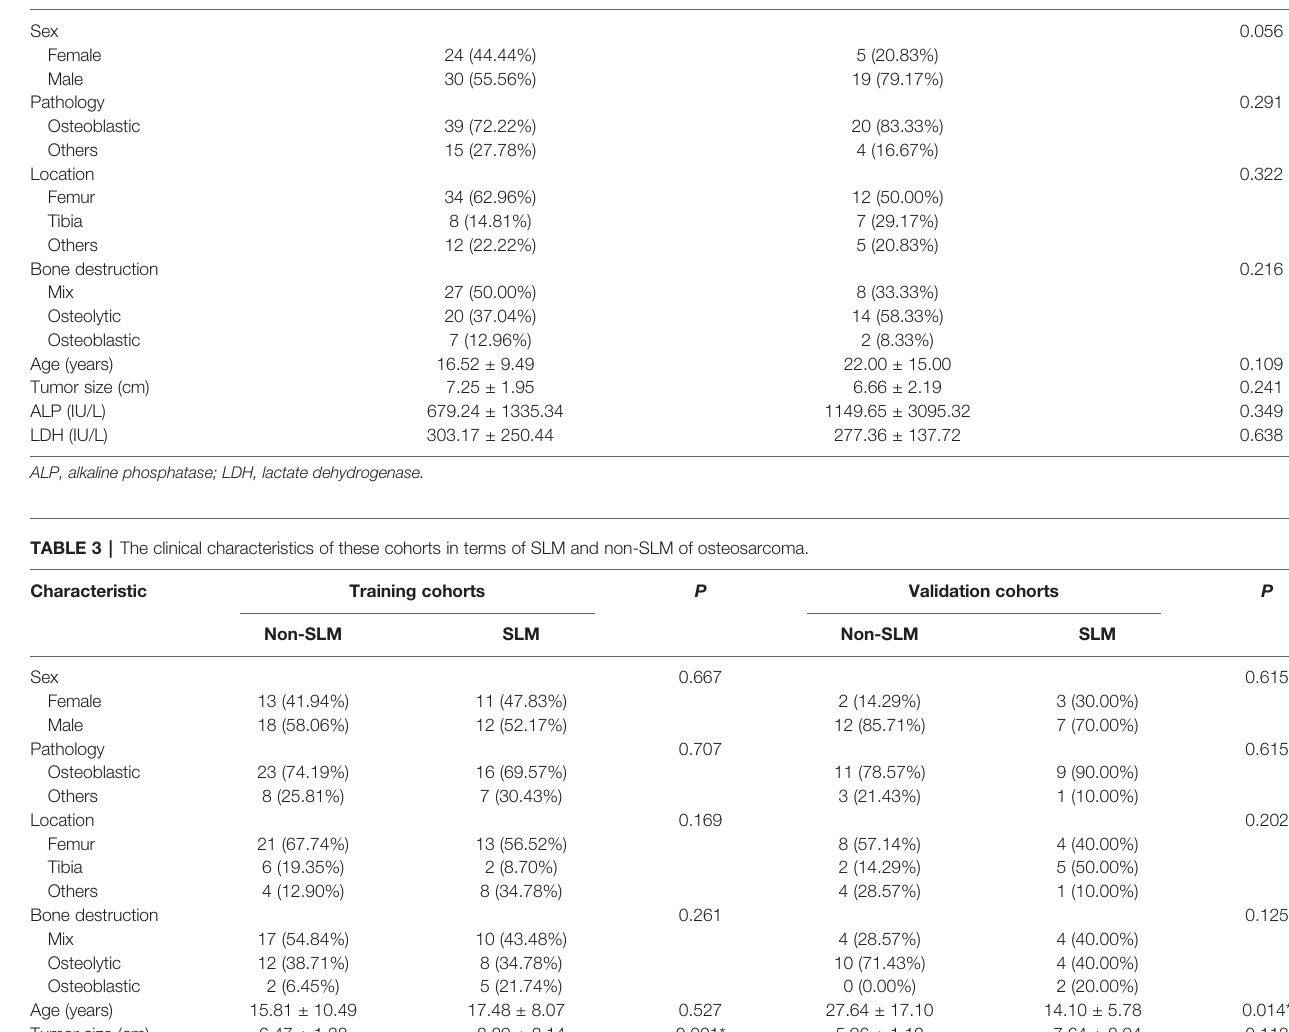
TABLE 2 | The clinical characteristics of the 78 osteosarcoma patients in the training and validation cohorts. Characteristic